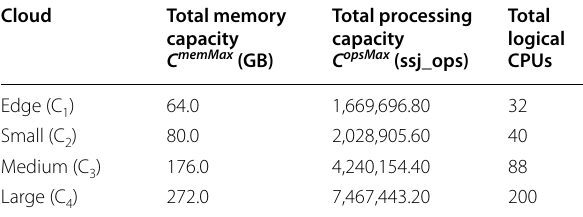
Table 4 Cloud parameters (Definitions in Tables 2 and 3)